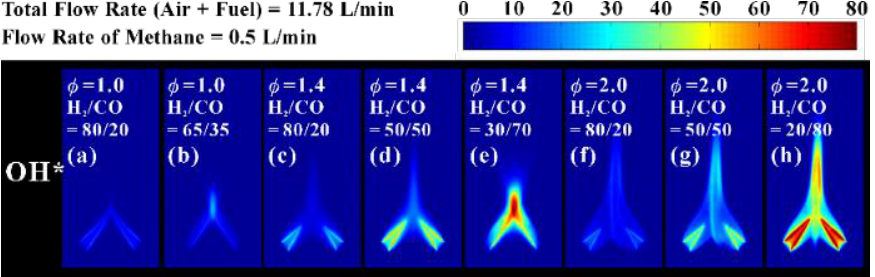
Figure 9. Distribution of OH* chemiluminescence in CH 4 /syngas/air premixed impinging flames with varied equivalence ratios and H 2 /CO proportions.